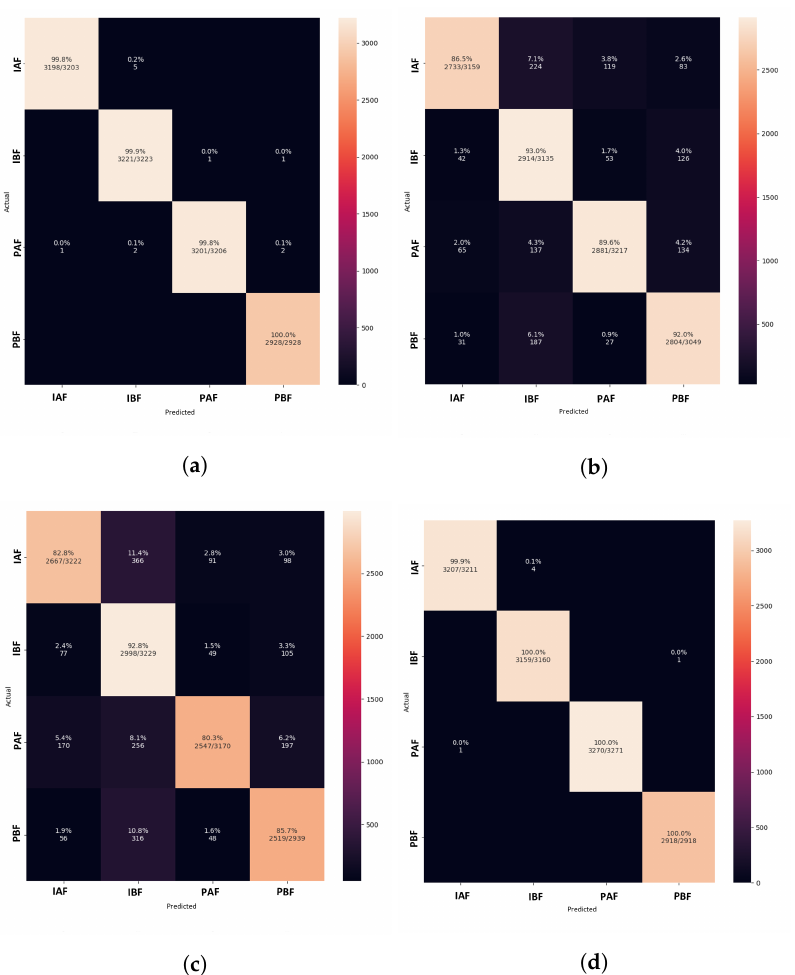
Figure 12. Confusion matrix of image classification models for learning rate = 0.001. ( a ) LeNet5. ( b ) AlexNet. ( c ) VGGNet. ( d )